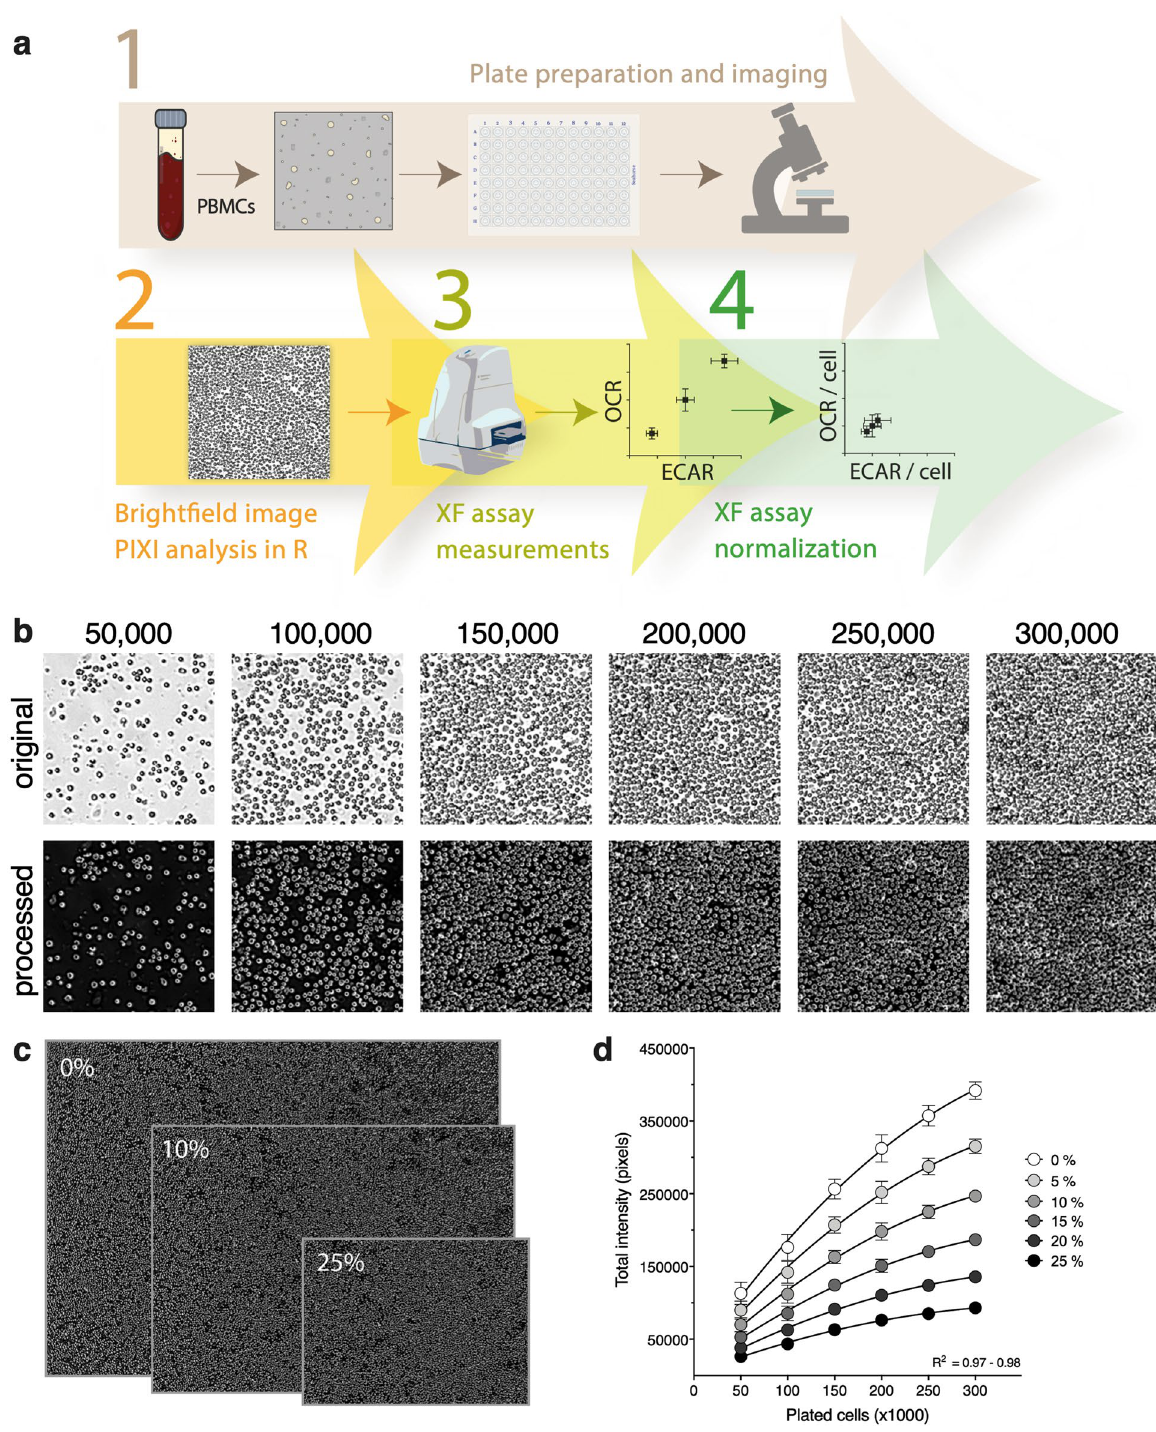
Figure 2. R-integrated pixel intensity (PIXI) analysis from brightfield images integrated in the PBMC XF assay workflow. ( a ) Method workflow for PBMC XF assay data normalization using brightfield image analysis. ( b ) Original pre-XF assay brightfield images (top, 4 × objective) were processed using an in-house generated R script, generating images in which the total pixel intensity was quantified (bottom). A magnification from the middle of the brightfield image is shown for each seeding density (n = 14–16), for one donor. ( c ) Effect of 0%, 10% and 25% image border cropping on the size of the processed image at a seeding density of 200,000 cells/ well. Images have the same scale bar. ( d ) Effect of border cropping percentage (0–25%) on the curve fit of plated cells versus total pixel intensity